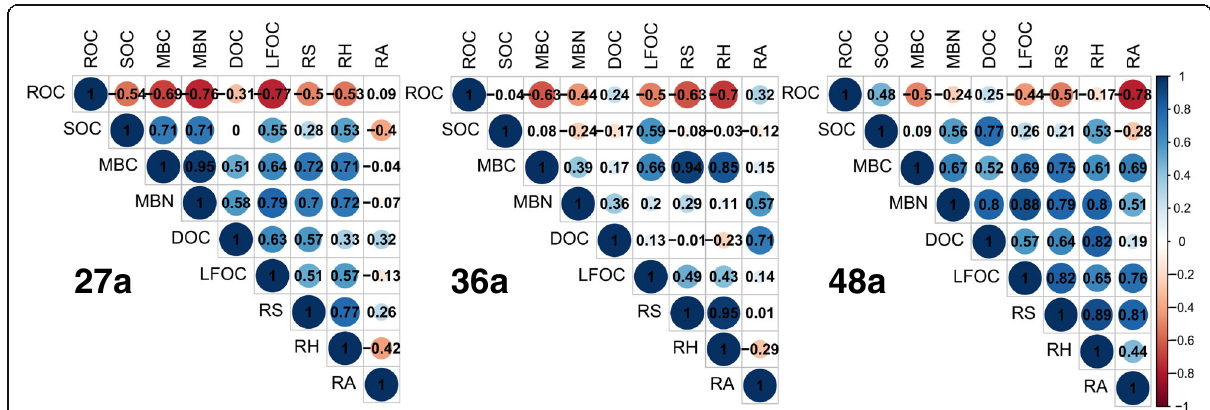
Fig. 6 Correlations between the Rs, Rh, Ra, and the SOC and soil labile organic carbon for different aged stands. SOC, soil organic carbon; DOC, soil dissolved organic carbon; MBC, microbial biomass carbon; LFOC, light fraction organic carbon; ROC, readily oxidized carbon; Rs, soil respiration; Rh, heterotrophic respiration; Ra, autotrophic respiration. 27a, 27-year-old stand; 36a, 36-year-old stand; 48a, 48-year-old stand